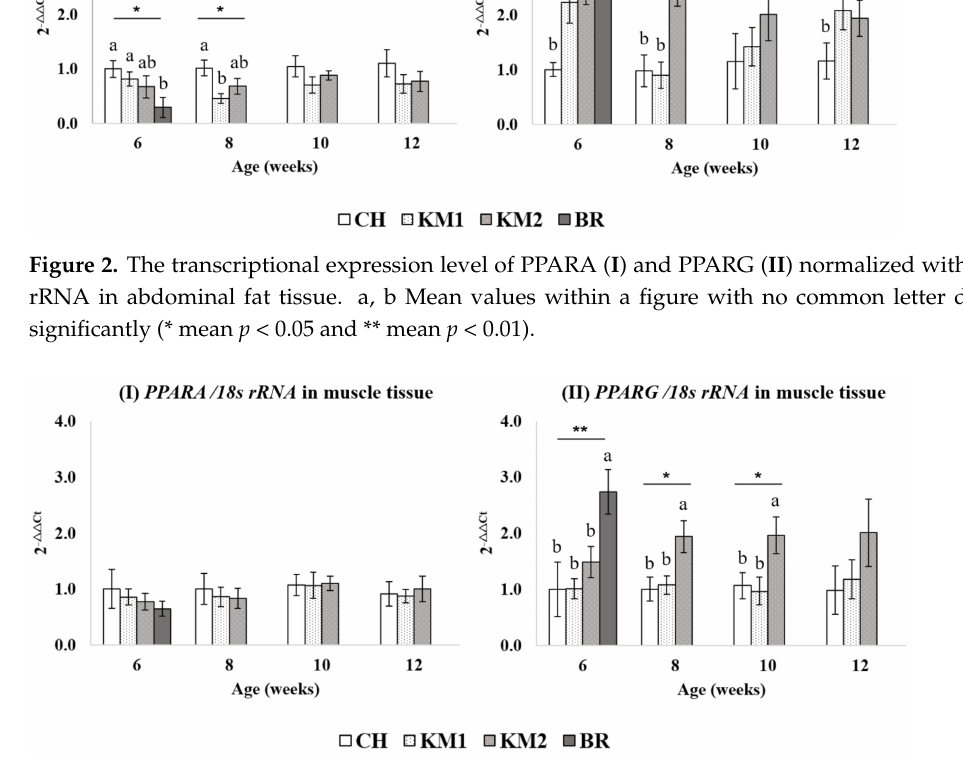
Figure 3. The transcriptional expression level of PPARA ( I ) and PPARG ( II ) normalized with 18S rRNA in breast muscle tissue. a, b Mean values within a figure with no common letter differ significantly (* mean p < 0.05 and ** mean p <